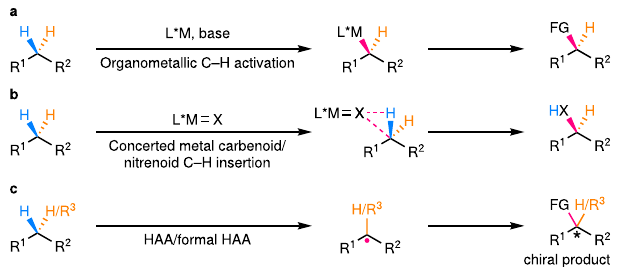
Fig. 1 General strategies for enantioselective C( sp 3 ) – H functionalization.